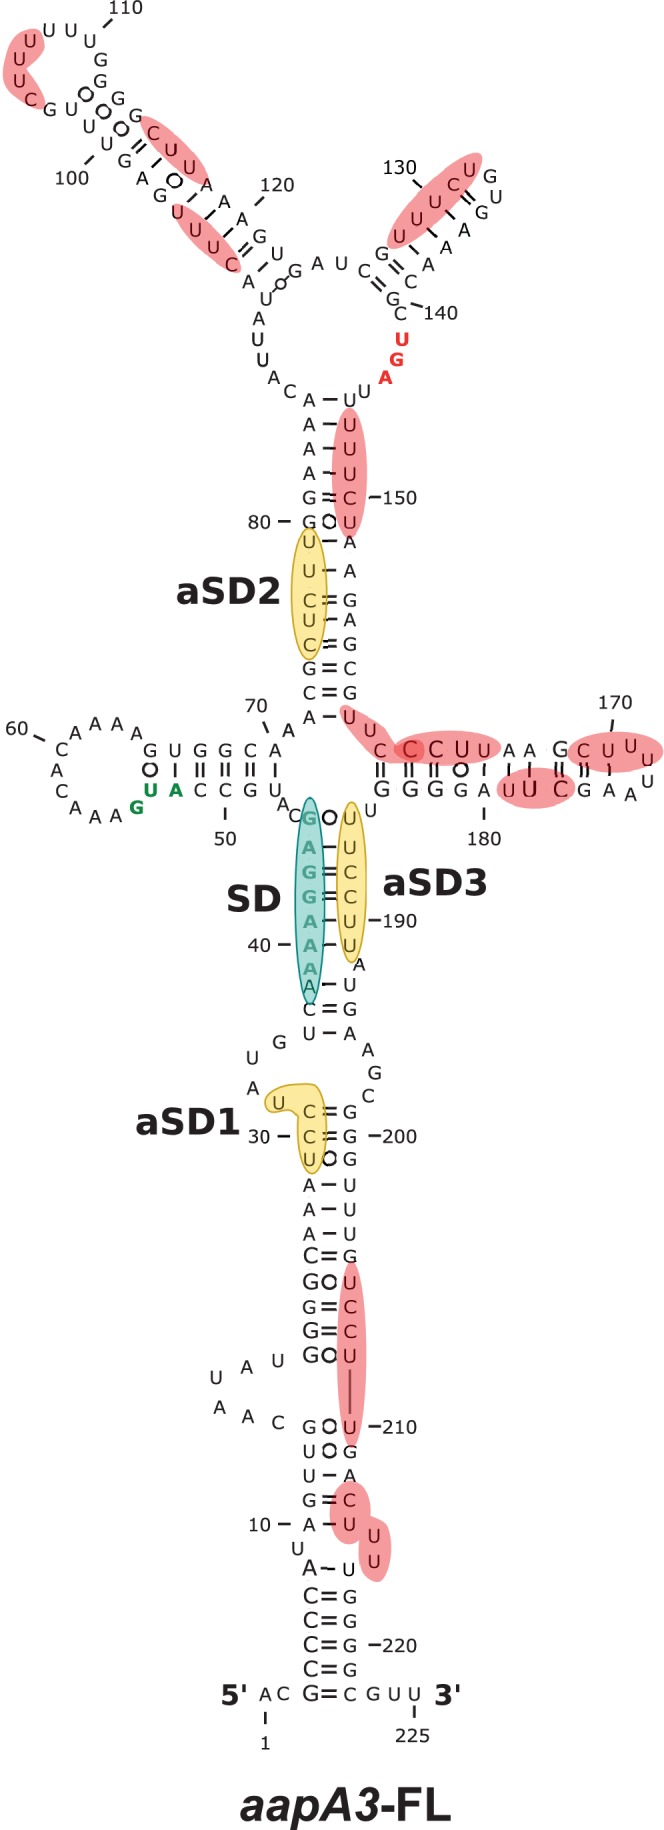
Only three out of the 13 potential aSD sequences embedded in aapA3 mRNA are functional.2D structure predictions were generated with the RNAfold Web Server (Gruber et al., 2008) with no additional constrains and VARNA (Darty et al., 2009) was used to perform the drawing. Potential, but not used, anti-Shine-Dalgarno (aSD) sequences (UC-rich motifs) are highlighted in red. The three functional aSD sequences (aSD1, aSD2, aSD3) are shown in gold. Shine-Dalgarno (SD) sequence is shown in turquoise. Translation start and stop codons are shown in green and red, respectively.